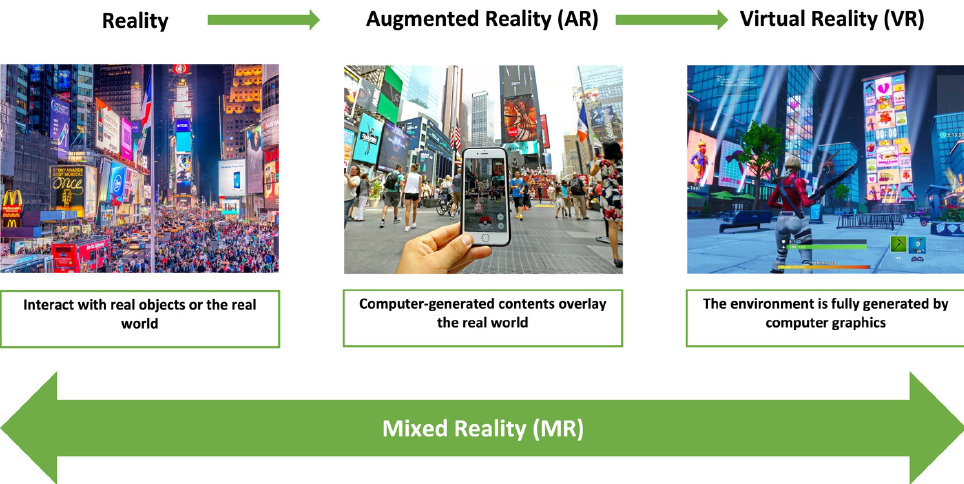
Figure 2. Milgram and Kishino’s Mixed Reality